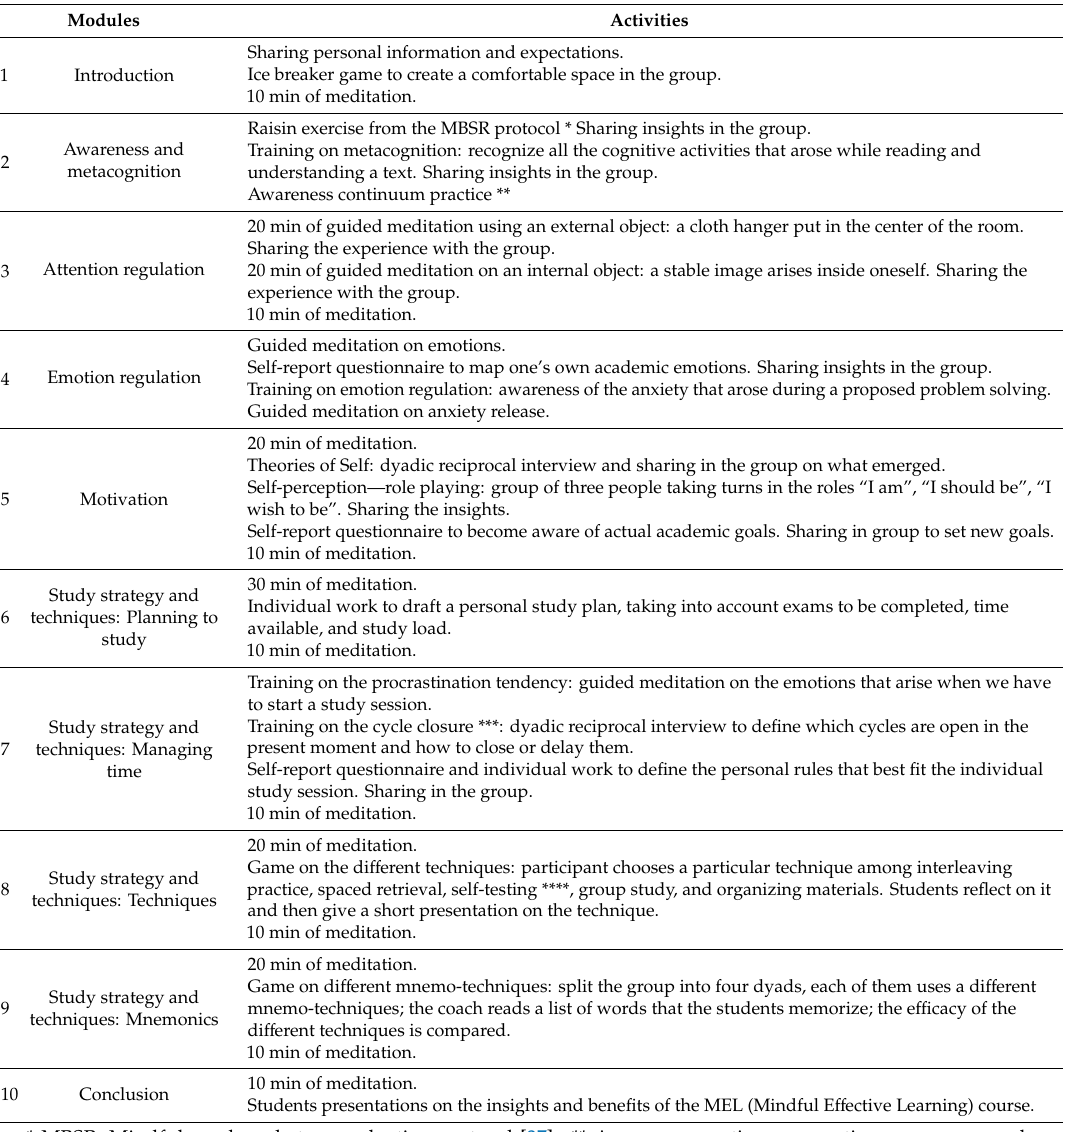
Table 1. Activities involved in the mindfulness-based group coaching for each